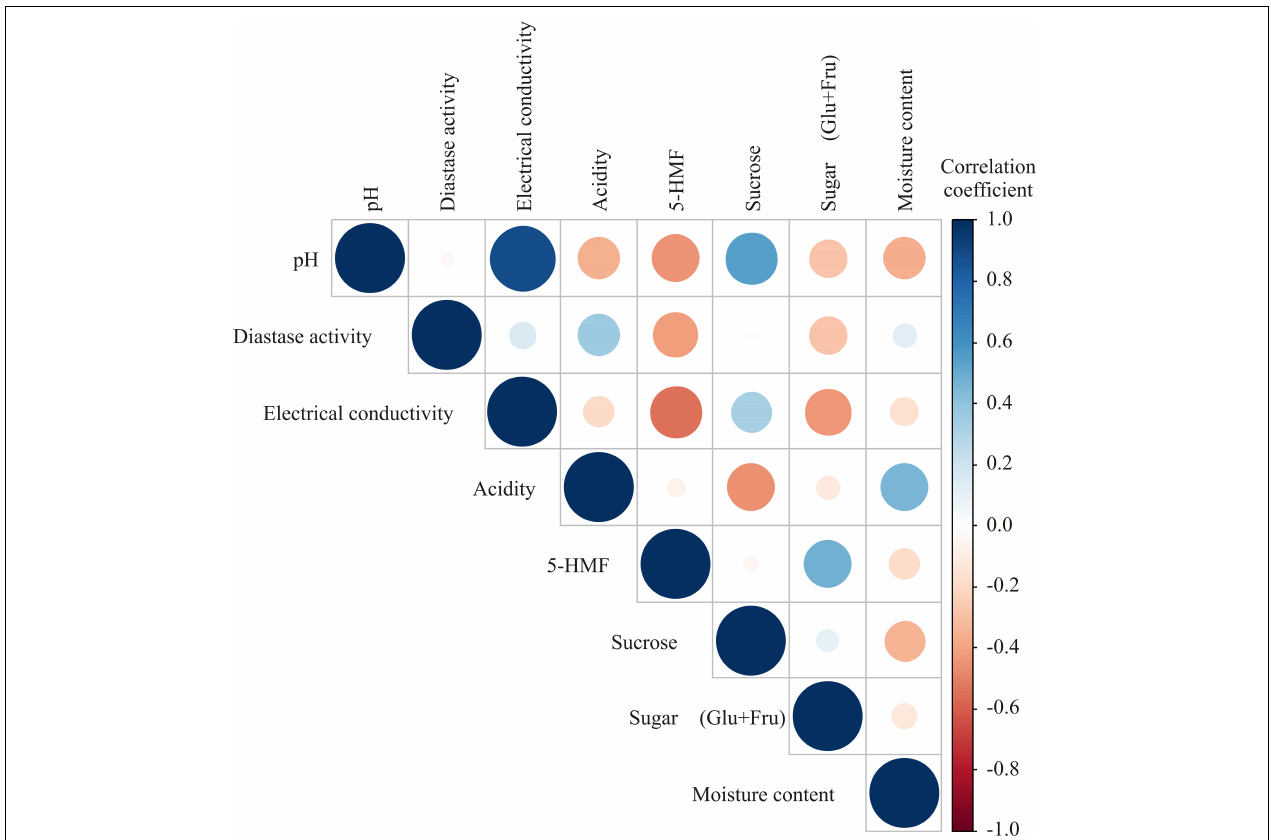
FIGURE 4 | Color correlation graph between physicochemical parameters in honey